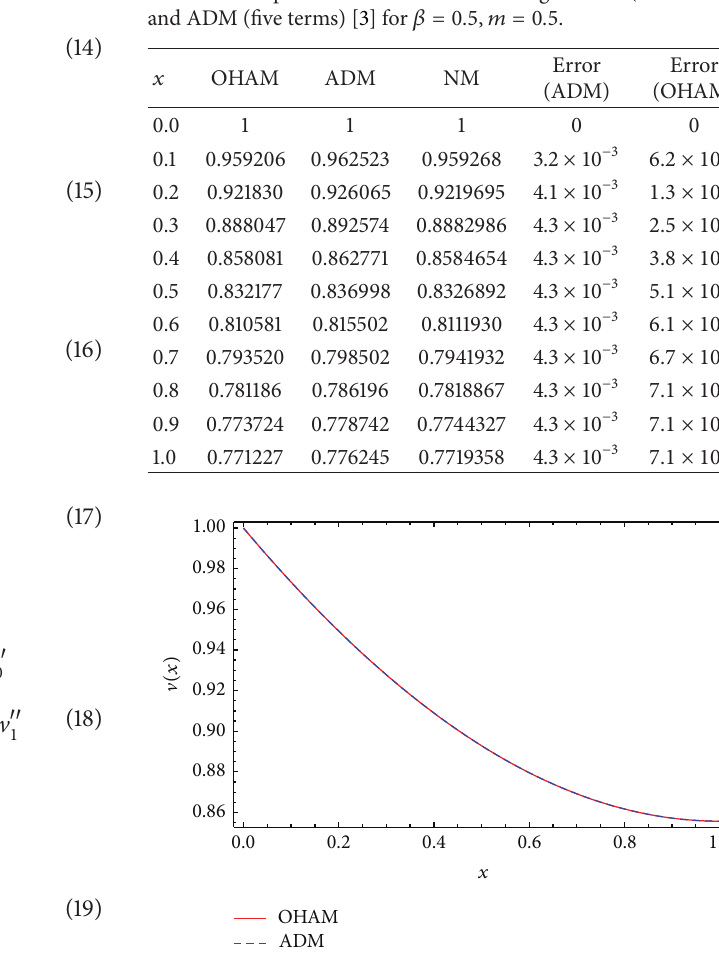
Figure 1: Comparison of velocity profile using OHAM (three terms) and ADM [3] (five terms) for 𝛽 = 0 . 5, 𝑚 = 0 .